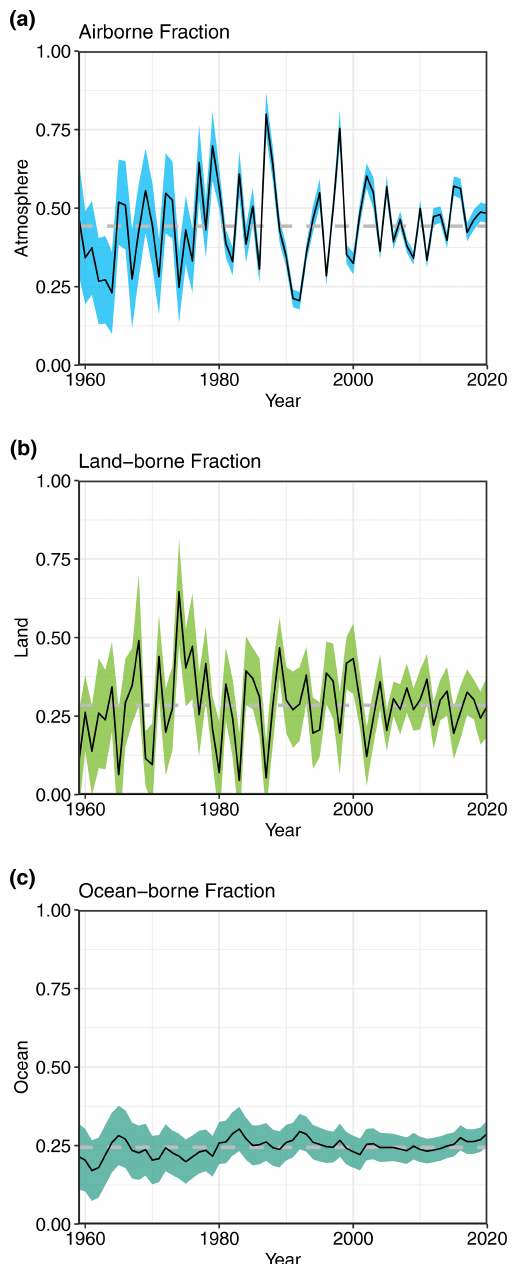
Figure 8. The partitioning of total anthropogenic CO 2 emis- sions ( E FOS + E LUC ) across (a) the atmosphere (airborne fraction), (b) land (land-borne fraction), and (c) ocean (ocean-borne fraction). Black lines represent the central estimate, and the coloured shad- ing represents the uncertainty. The grey dashed lines represent the long-term average of the airborne (44%), land-borne (28%), and ocean-borne (24%) fractions during 1959–2020.